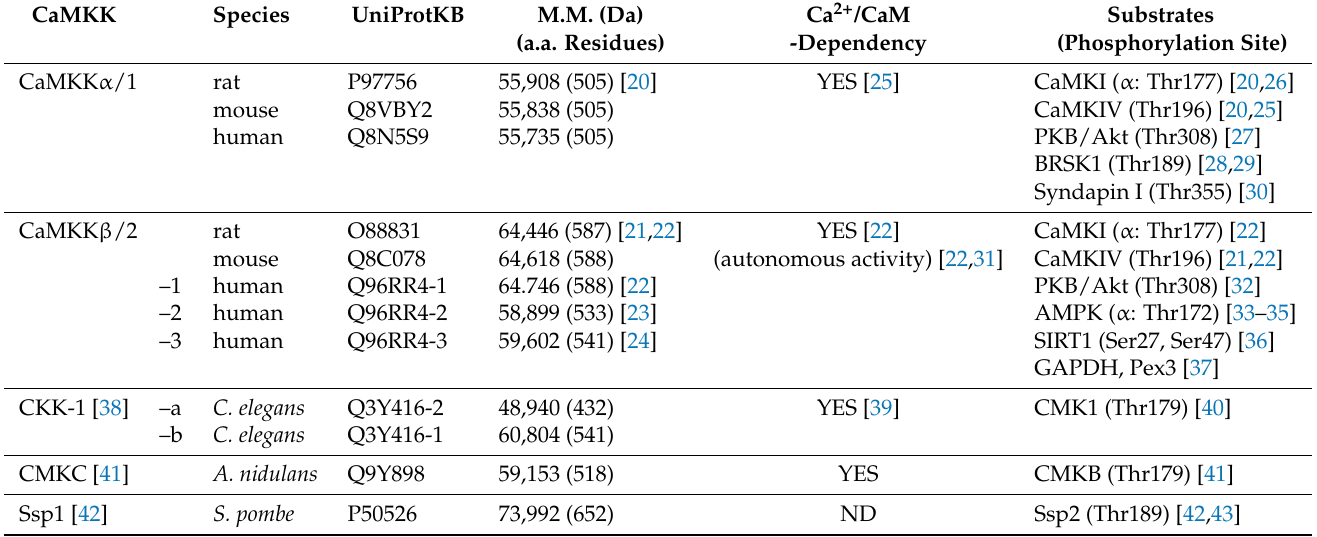
Table 1. CaMKK in eukaryotic